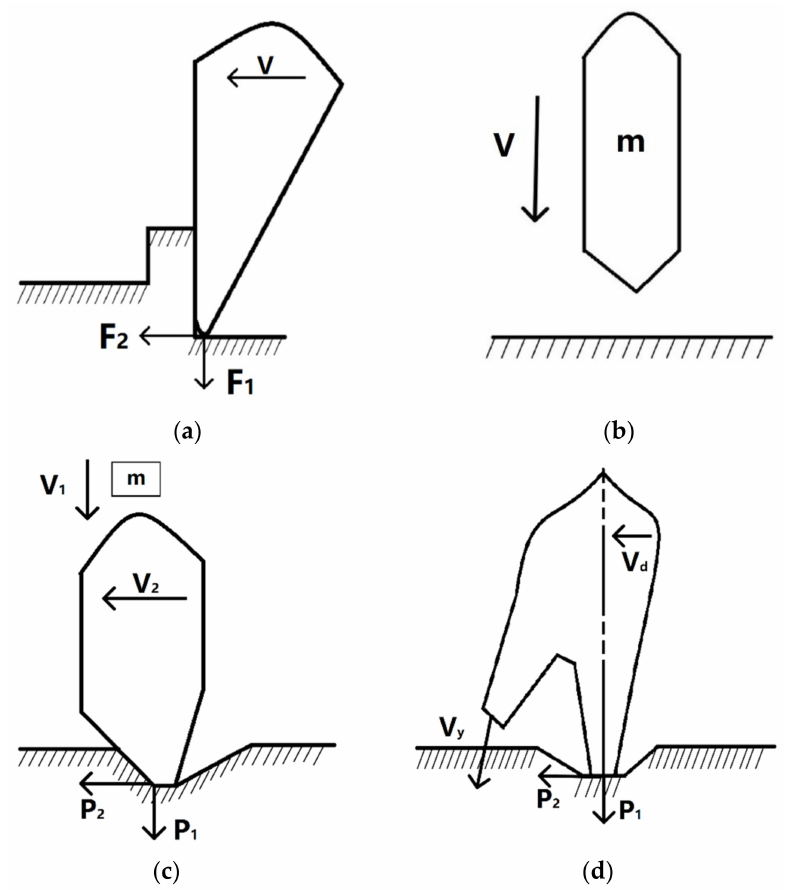
Figure 1. Schematic of the drill rock blade with rock. ( a ) Cutting and shearing mode F 1 is the axial force. F 2 is the tangential force. V is the speed of the bit. ( b ) Chiseling crushing mode. m is the mass of the drill tool. V is the impact velocity. ( c , d ) Chiseling crushing shear mode. P 1 is the axial force. P 2 is the tangential force. V 1 is the impact velocity. V 2 is the forward speed of the bit. m is the mass of the drill tool. V y is the velocity of adjacent teeth. V d is the speed of the bit.